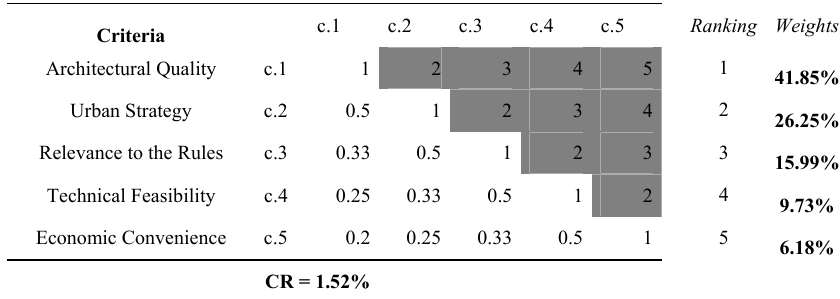
Figure 3. Matrix of pairwise comparison of the criteria.